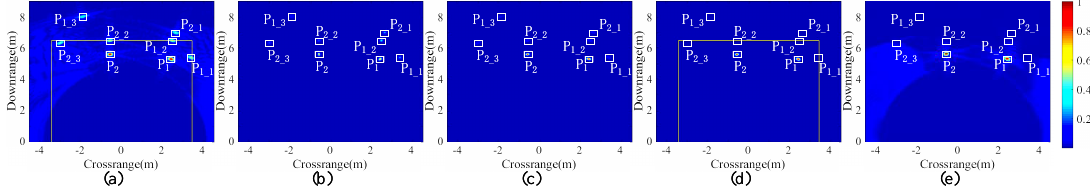
Figure 12. The selected sample for quantitatively evaluating multipath-ghost suppression for different methods. ( a ) The original images. ( b ) The PCF method. ( c ) The subaperture-fusion method. ( d ) The imaging-dictionary-based method. ( e ) The proposed method. The white rectangles mark the regions of target images and their multipath ghosts. Table 4. Ratios between the peaks of the target images and their multipath ghosts (dB).